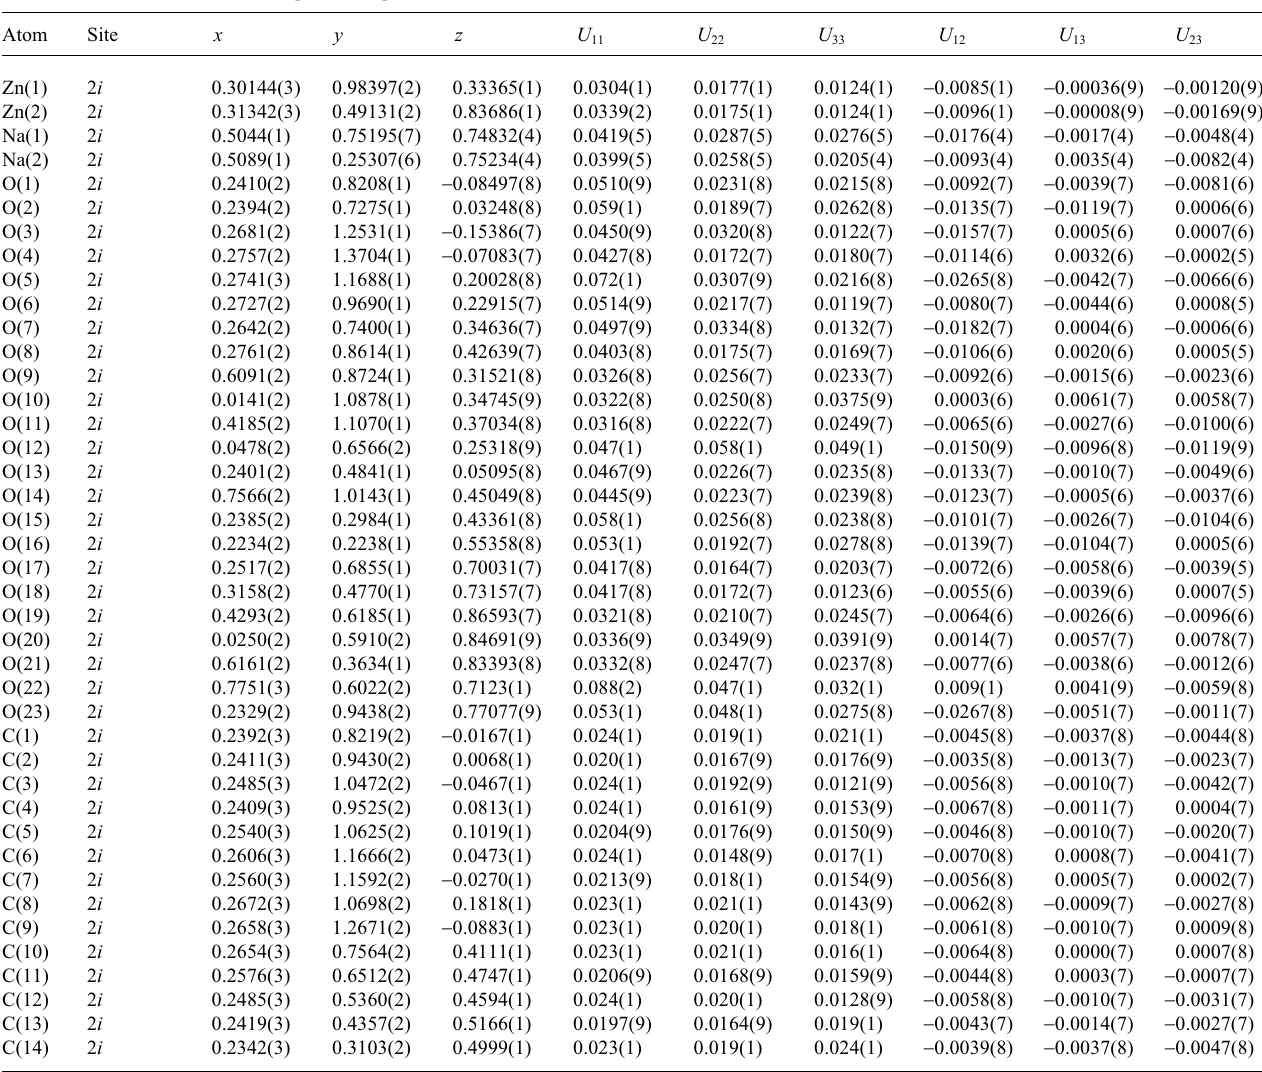
Table 3. Atomic coordinates and displacement parameters (in Å 2 ).